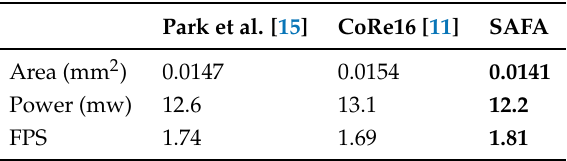
Table 3. Area, power, and FPS evaluation for the PE in SAFA and other reconfigurable accelerators. The PE of SAFA also achieves higher FPS in contrast with other reconfigurable accelerators while maintaining lower power and